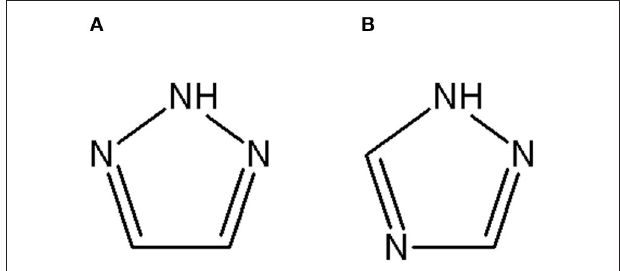
FIGURE 1 | Structures of the two isomeric forms of triazoles. (A) 1,2,3-triazole; (B) 1,2,4-triazole (Souza and Miranda, 2019).